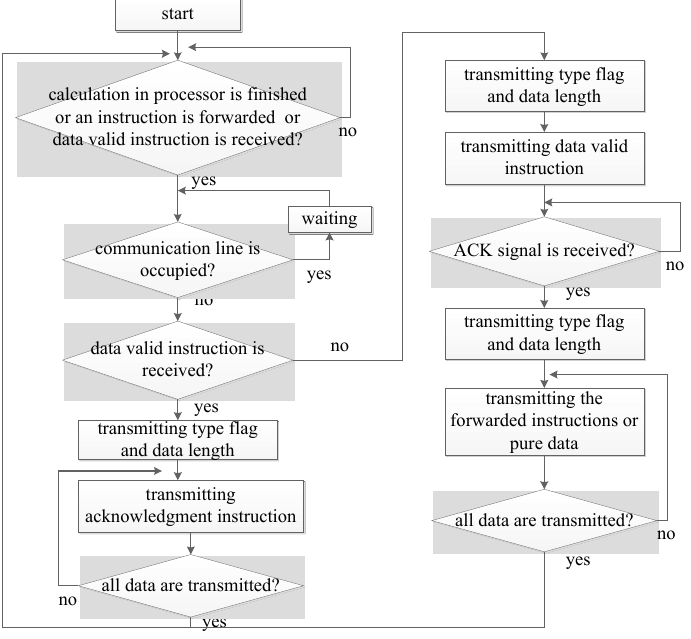
Figure 6. Data transmission.